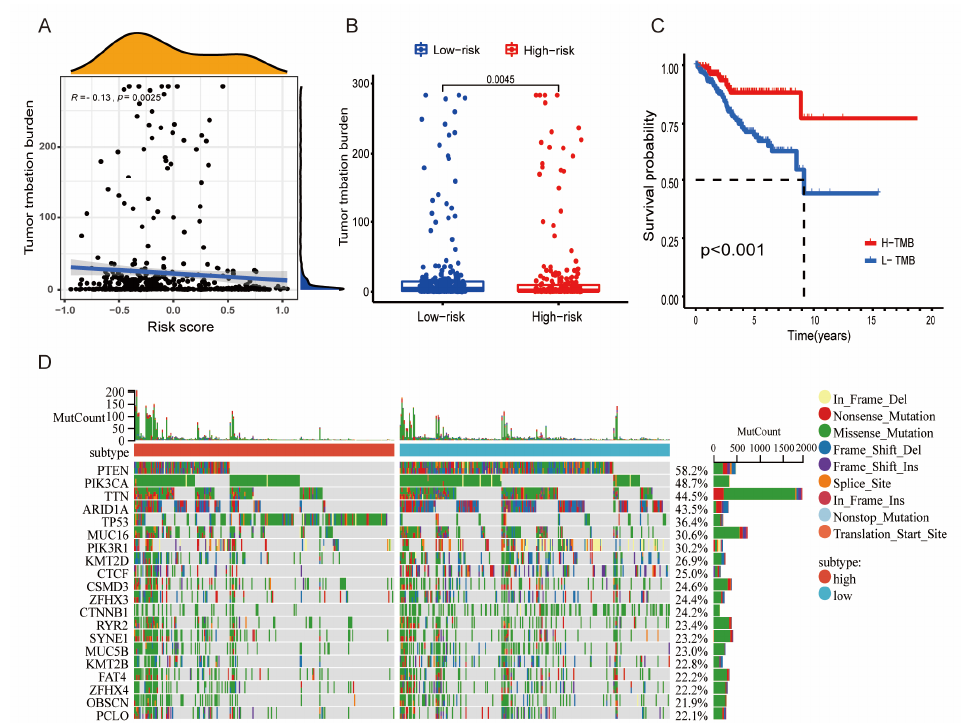
Figure 5. Relationship between the tumor mutational burden (TMB) and the risk model. ( A ) Rela- tionship between TMB and risk score. TMB was negatively associated with risk score. (R = − 0.13, p < 0.05). ( B ) The result showed that patients in high-risk group had lower TMB levels. p < 0.05 ( C ) The K-M analysis presents the difference in overall survival between the low- and high-TMB groups. In addition, patients with high TMB had a better prognosis, p < 0.05. ( D ) The waterfall plot shows the mutation information of the top 20 genes in each UCEC